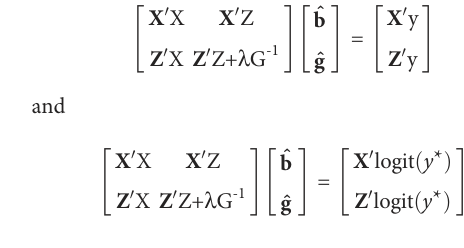
TABLE 1 Single nucleotide polymorphism (SNP) information. Chromosome Number of SNPs Span of SNPs (kb) Distance between adjacent markers